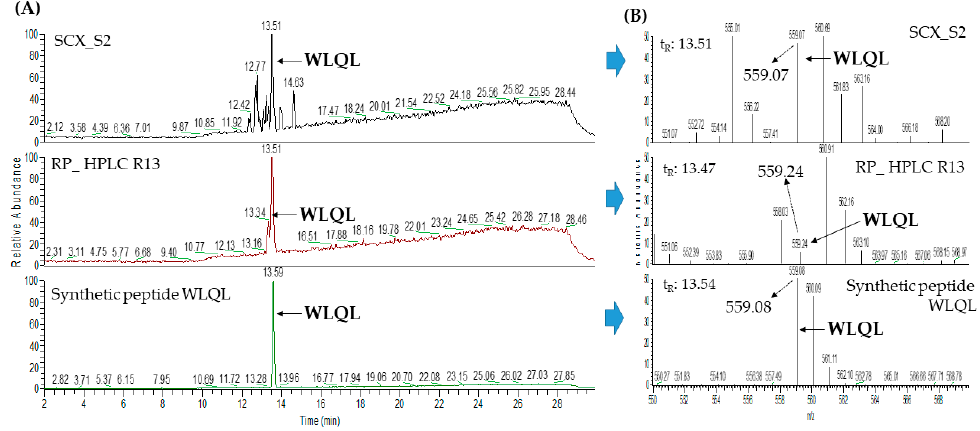
Figure A5. ( A ) LC–MS chromatograms of SCX S2, RP R13, and the synthetic peptide WLQL, ( B ) MS spectra of WLQL originated from fraction SCX S2 ( m / z 559.07, t R 13.51 min), fraction RP R13 ( m / z 559.24, t R 13.47) and synthetic WLQL ( m / z 559.08, t R 13.54). Pharmaceuticals 2020 , 13 , x FOR PEER REVIEW 20 of 23